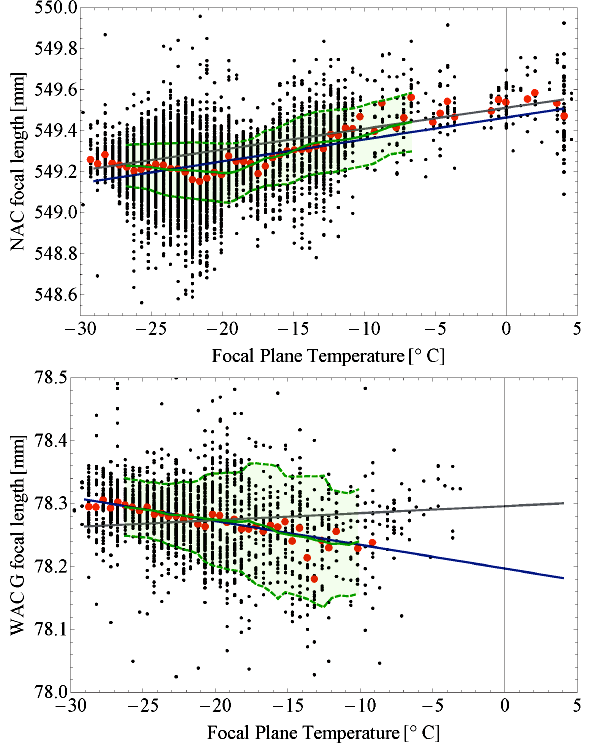
Fig. 3: NAC and WAC (Filter G) focal length as function of focal-plane temperature. The black dots denote the focal lengths of the images obtained through bundle-block adjustment. The red dots are mean values of focal lengths of the same temperature. Note: The precision of the temperature measurement is only 0.5°C. Mean values were not calculated for temperature regime with data from less than 5 images. The green line denotes the averages of the focal lengths within temperature bins of 5 degrees. The green shaded area with the dashed green lines depicts the standard deviation within the temperature bins. The blue line is a linear fit to the green curve, while the standard deviations of the binned data were used as weights. The grey line is the model proposed by Denevi et al. (2017). (Note: Denevi et al. (2017) list 1.117 × 10 − 2 mm/°C for the WAC focal length effect, probably a typo. The corresponding instrument SPICE kernel to which the authors refer shows 1.117 × 10 − 3 mm/°C. The figure shows the value reported in the instrument kernel.)